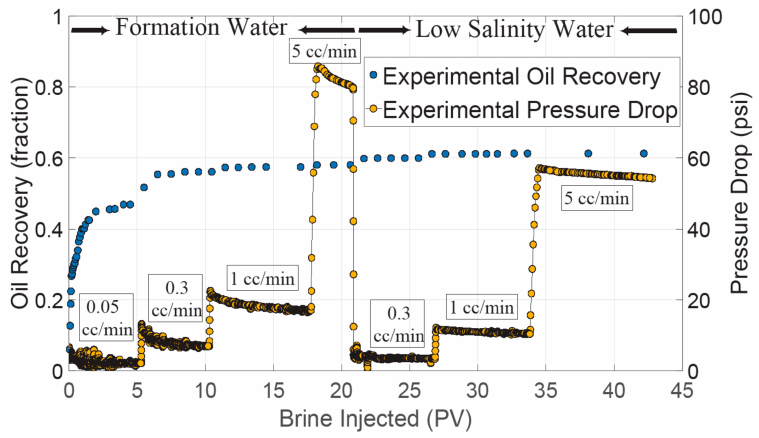
Figure 2. Oil recovery and pressure drop for